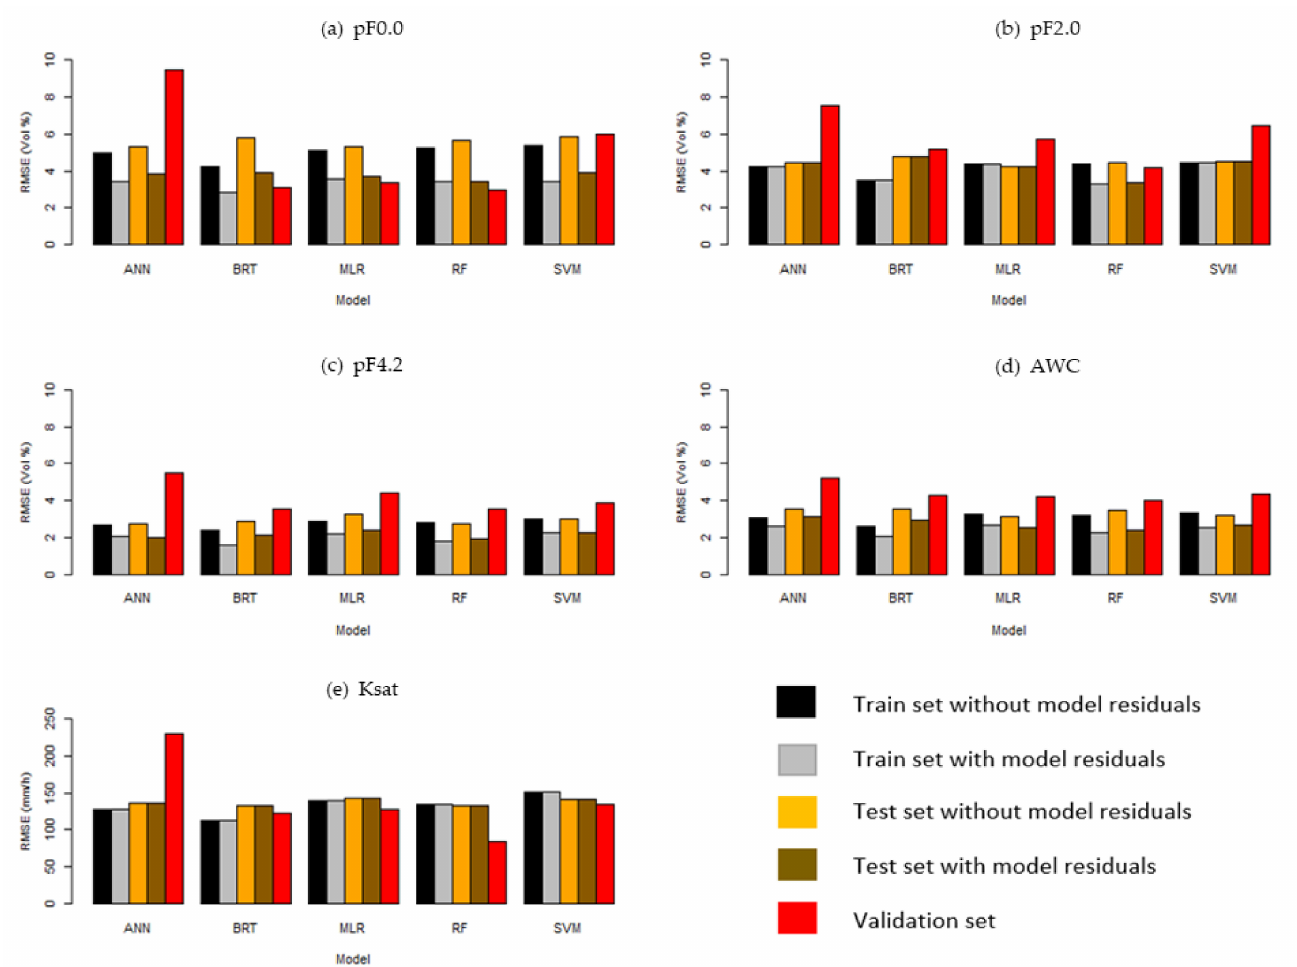
Figure 7. Root mean squared error (RMSE) for the five DSM models applied to the training sets without residuals (black), training sets with residuals (grey), test sets without residuals (orange), test sets with residuals (brown), and the validation data sets (red). ANN, artificial neural network; BRT, gradient boosted regression trees; MLR, multiple linear regression; RF, random forest; SVM, support vector machine. Panel ( a ) shows the response variable pF0.0, panel ( b ) for pF2.0, panel ( c ) for pF4.2, panel ( d ) for AWC and panel ( e ) for Ksat at a depth of 30 cm.